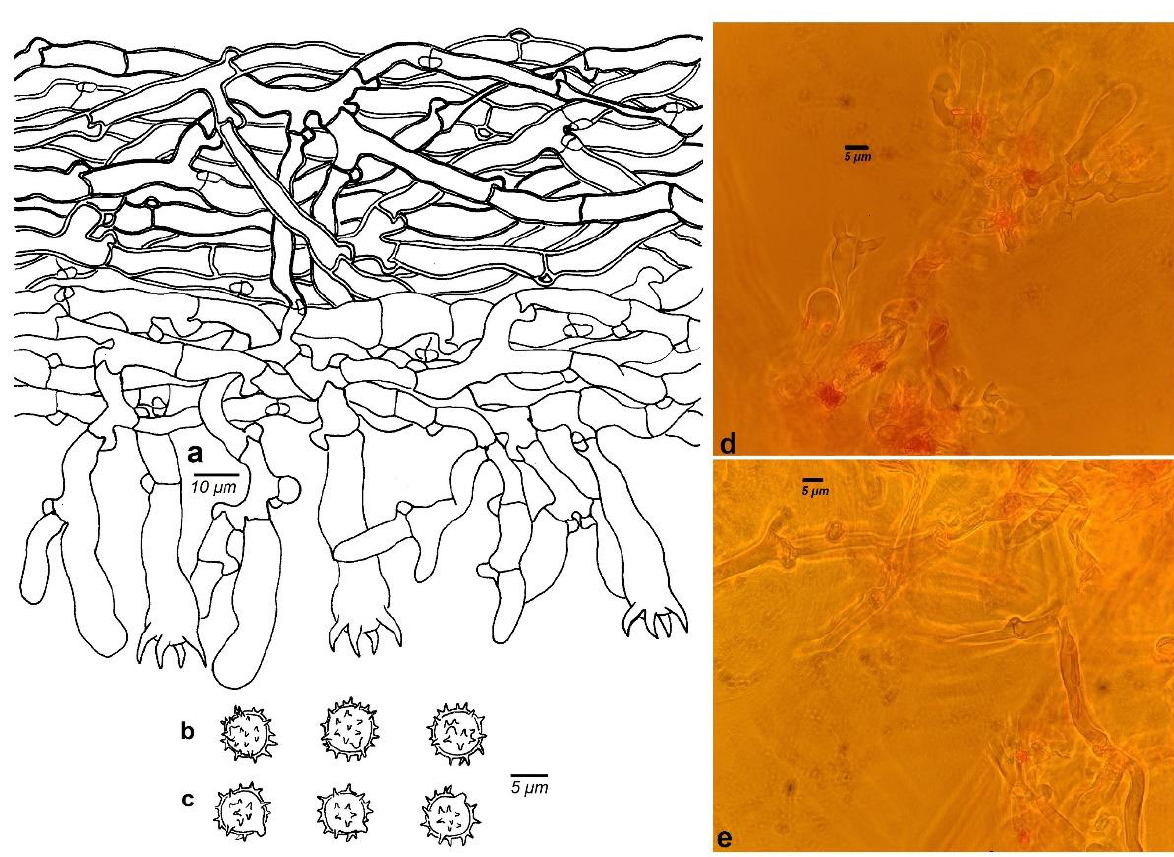
Figure 5. Microscopic structures of Tomentella kanasensis (drawn from holotype Yuan 14034). ( a ) A section through basidiocarp. ( b ) Basidiospores in frontal view. ( c ) Basidiospores in lateral view. ( d ) Optical microscope images of subhymenial hyphae and basidia. ( e ) Optical microscope images of subicular hyphae.